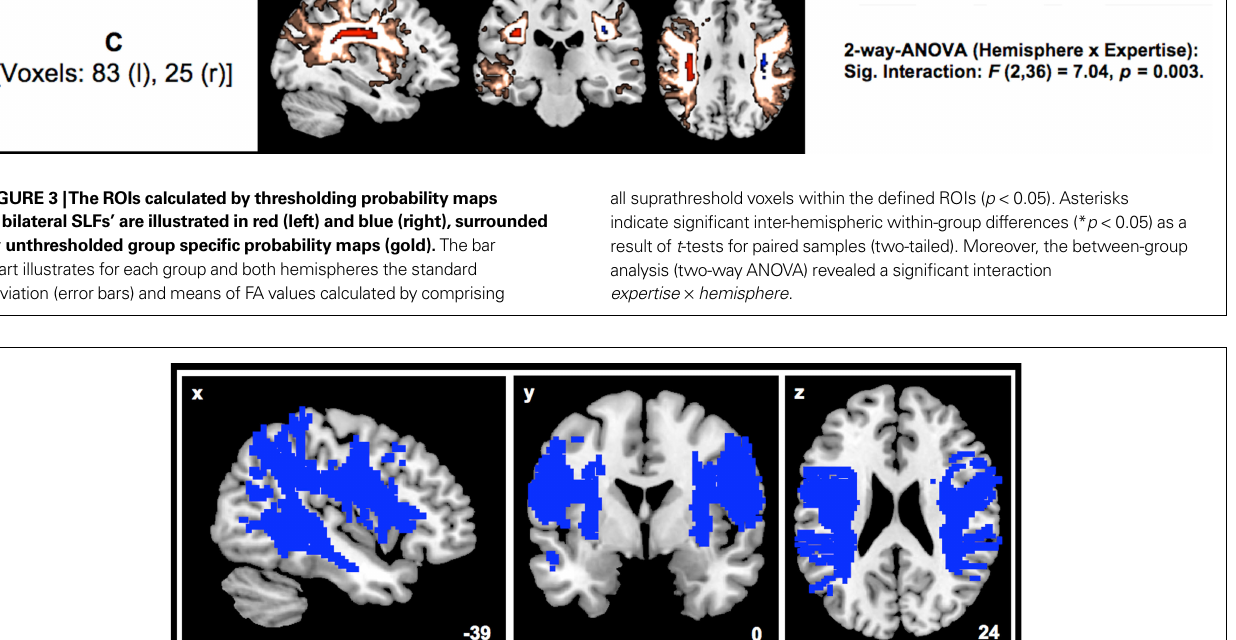
FIGURE 4 | The unthresholded probability map of the bilateral SLF served as template to create the illustrated binary mask while performing the voxel- wise analysis.